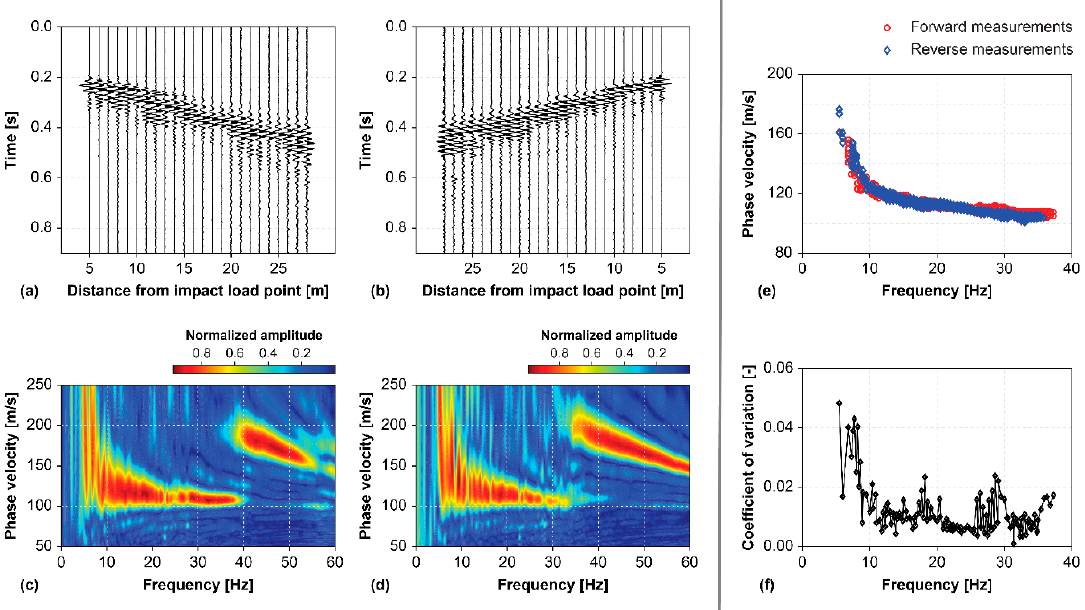
Figure 18. Examples of experimental data and dispersion processing results from the Halden test site. ( a , c ) Forward measurement and ( b , d ) reverse measurement. ( e ) Comparison of experimental dispersion curves identified from repeated forward and reverse shot gathers. ( f ) Variation of the extracted phase velocity vales at each frequency.